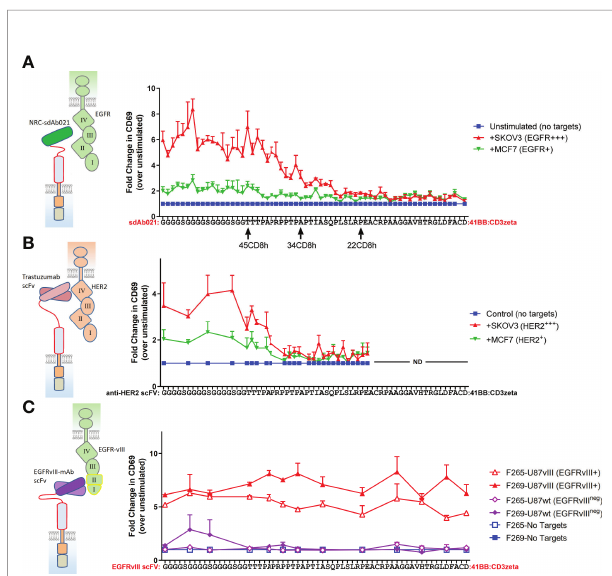
FIGURE 3 | Single amino acid truncations can throttle CAR antigenic sensitivity for membrane proximal epitope targeting CARs. (A) A range of sdCAR constructs were produced containing EGFR-speci fi c sdAb021 and N-terminally truncated versions of the linker-extended human CD8 hinge domains ranging between 1 and 62 residues in length. Jurkat cells were electroporated with the resulting constructs and then co-incubated at an effector to target ratio of 1:1 with EGFR-high SKOV3 cells or EGFR-low MCF7 cells. After overnight incubation, CAR/GFP+ cells were examined for activation via staining with APC-labelled anti-human CD69 antibody. (B) Similarly, HER2-speci fi c trastuzumab-derivative scFv CAR constructs were generated with hinge domains of varying lengths. CAR-expressing Jurkat cells were co-incubated with HER2-high SKOV3 cells or HER2-low MCF7 cells and then CAR-T activation was assessed. (C) Similarly, EGFRvIII-speci fi c CAR constructs were generated with hinge domains of varying lengths. CAR-expressing Jurkat cells were co-incubated with EGFRvIII-overexpressing U87vIII cells or EGFRvIII-negative U87wt cells and then CAR-T activation was assessed. All results show means +/- SEMs of three separate